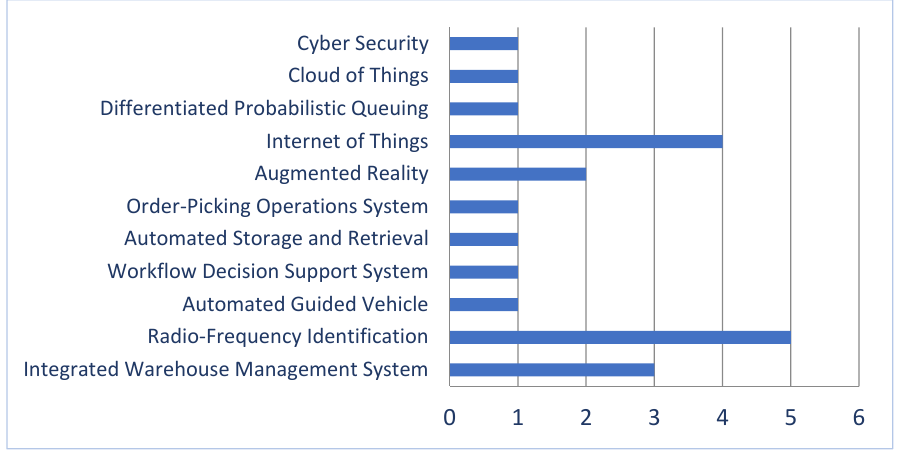
Figure 5. Summary of frequency of adopted technologies.